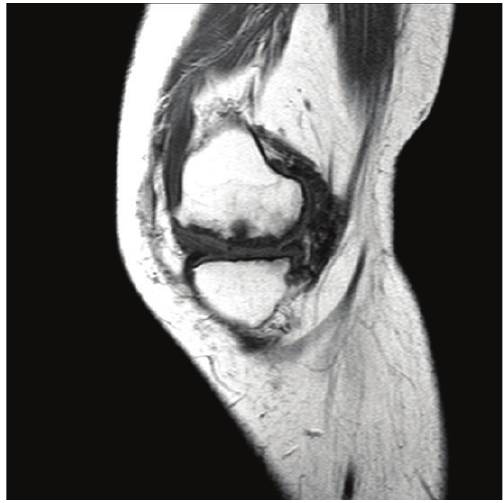
Figure 8: MRI T1 sagittal view of the left knee.